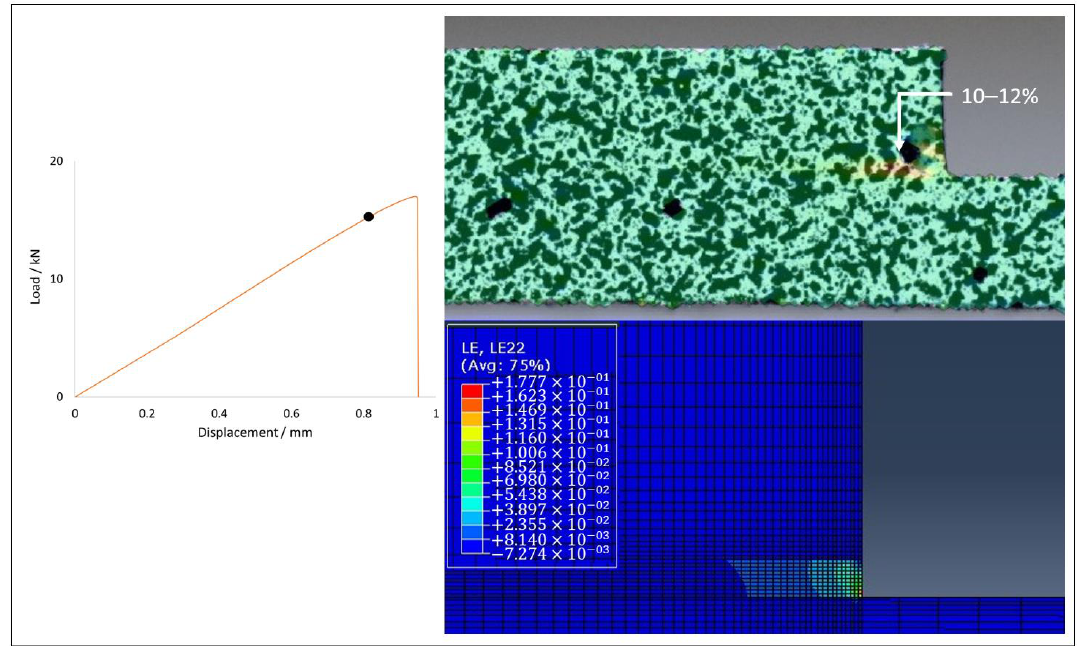
Figure 12. Strain field in CFRP joint: DIC (top) vs. numerical (bottom).